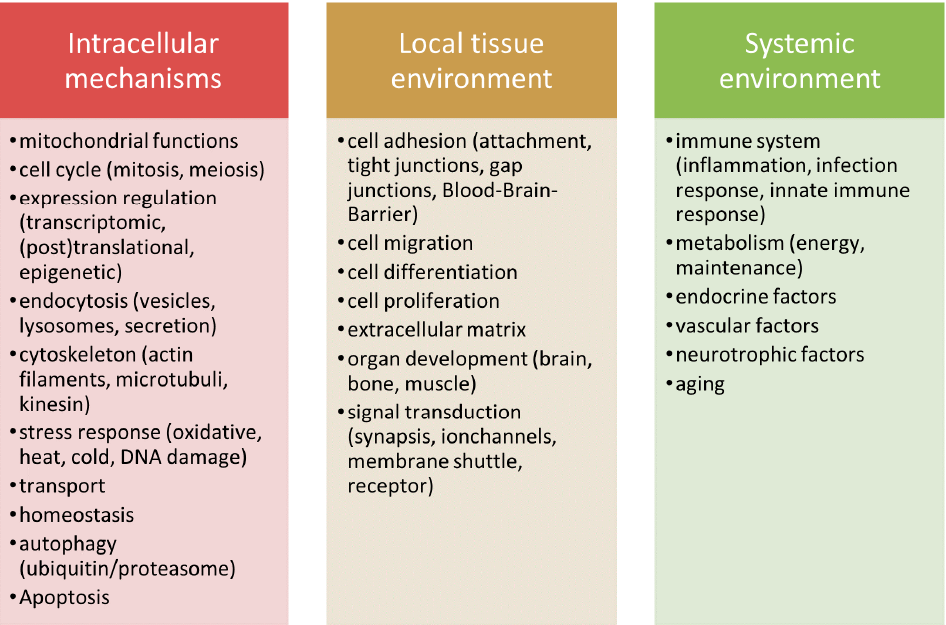
Figure 1. Classification of candidate pathways contributing to neurodegeneration into three groups according to their cellular mechanisms or their primary site of action. The categorization is based on Ramanan’s pathways to neurodegeneration [15] and aims to help in classifying the current knowledge surrounding neurodegeneration.